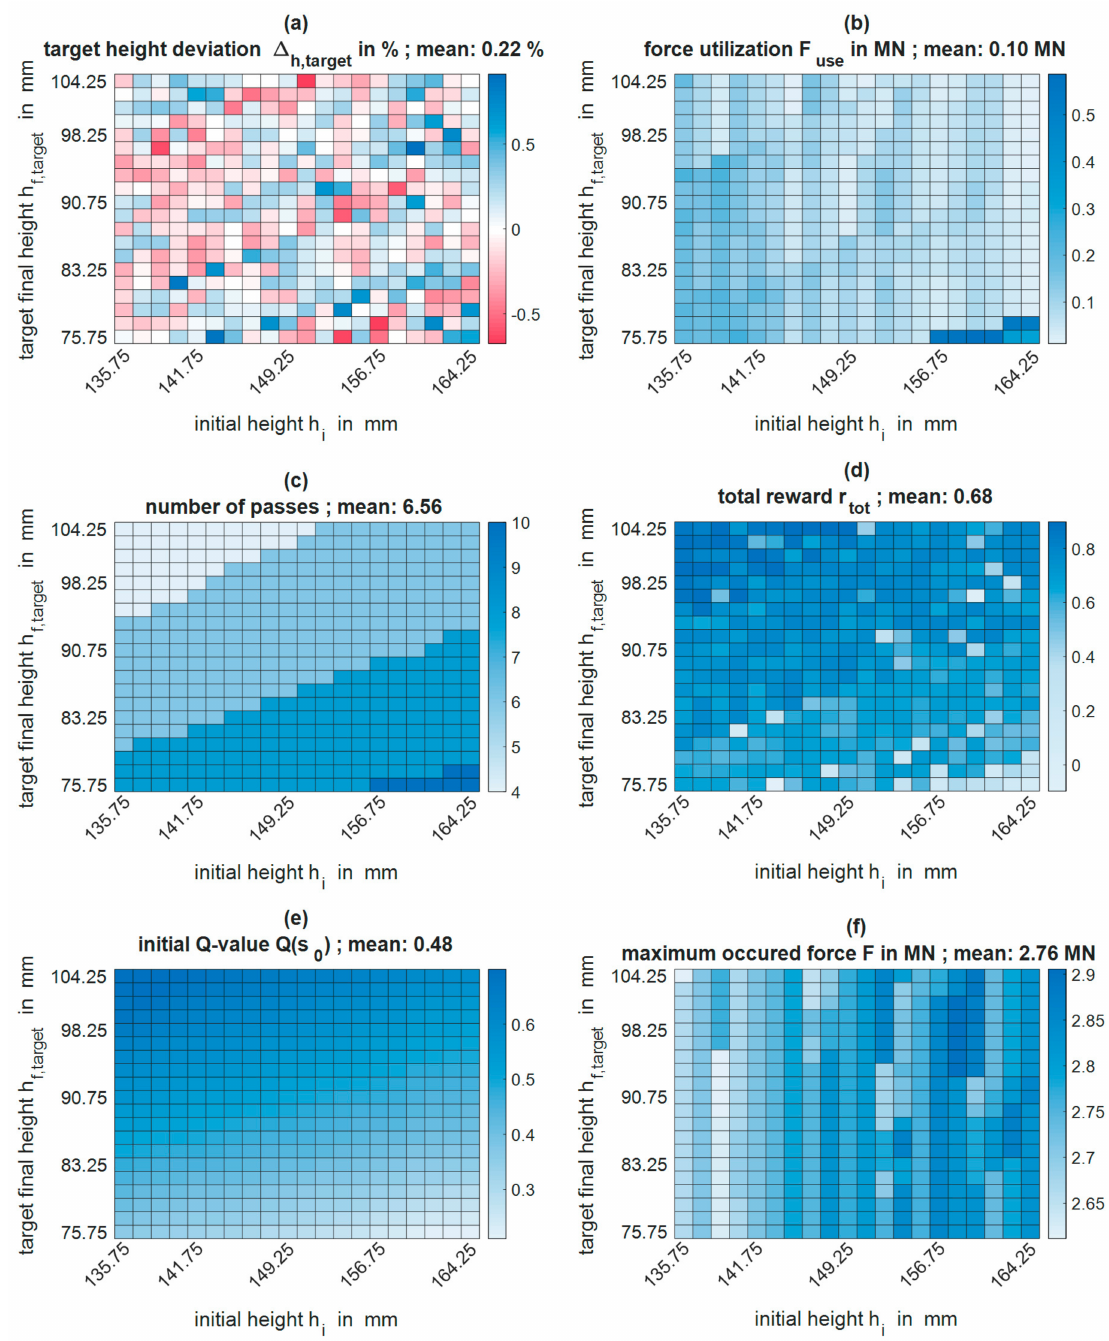
Figure A4. Heatmaps of the training results (best agent) of the forging experiment: ( a ) the target height deviation, ∆ h , target , ( b ) the mean force utilization, F use , ( c ) the mean number of passes, n p , ( d ) the total reward r tot , ( e ) initial Q-value Q ( s 0 ) , and ( f ) the maximum occurred force in a single pass schedule, F